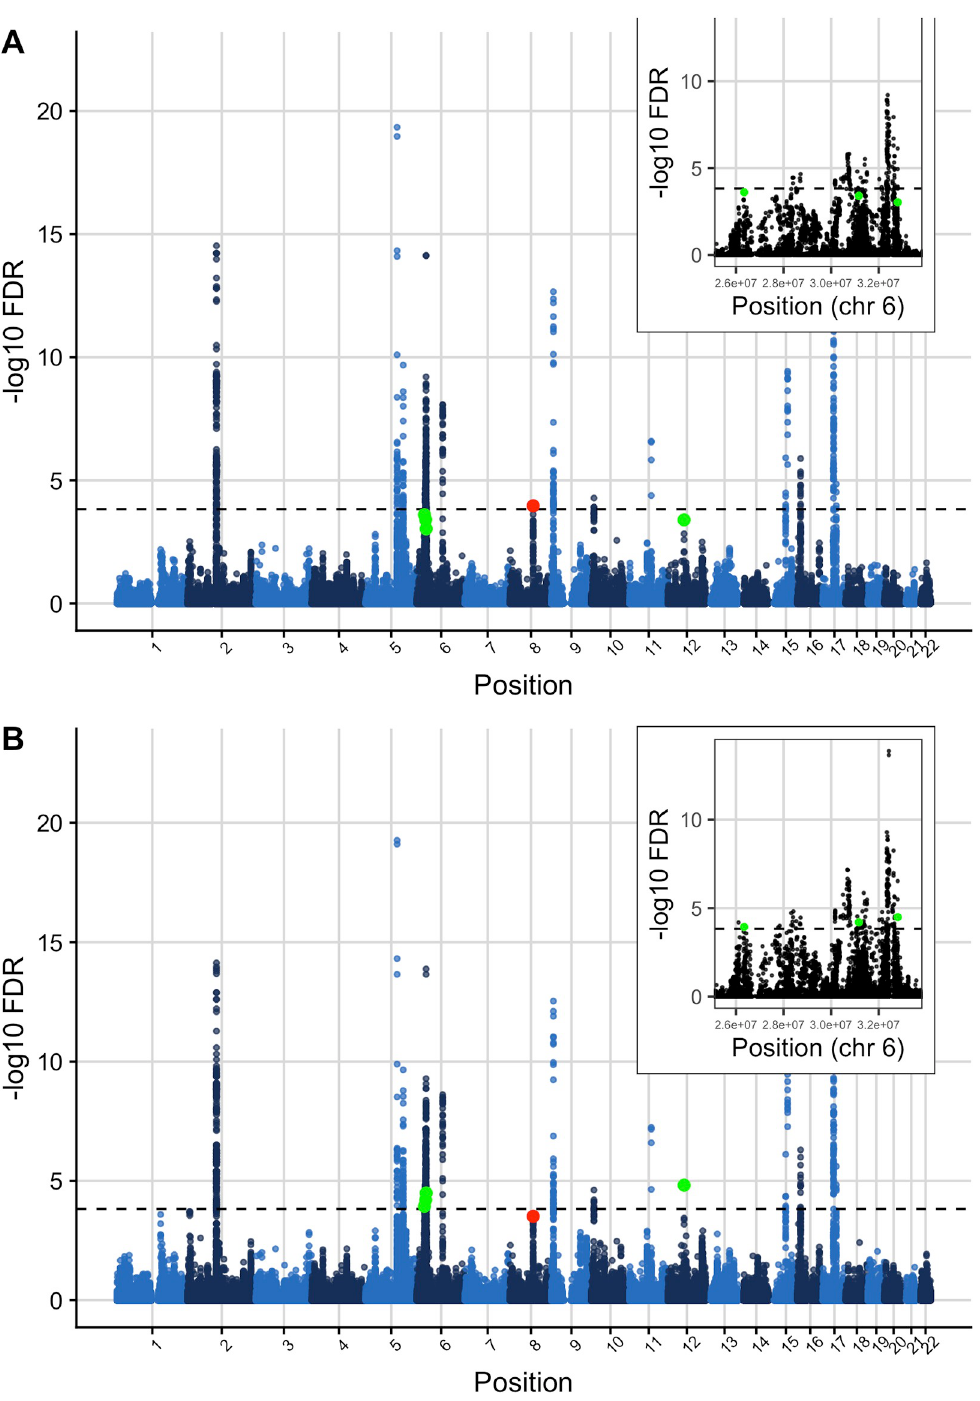
Fig 4. Manhattan plot of FDR values before and after applying Flexible cFDR to leverage H3K27ac data with asthma GWAS p -values. Manhattan plots of -log 10 FDR values before (A) and after (B) applying Flexible cFDR leveraging H3K27ac counts in asthma relevant cell types. Points are coloured by chromosome and green points indicate the four index SNPs that are newly identified as FDR significant after Flexible cFDR (rs167769, rs9467715, rs9501077 and rs4148869) whilst the red point indicates the single index SNP that was newly identified as not FDR significant by Flexible cFDR (rs12543811). Black dashed line at FDR significance threshold [ − log 10 (0.000148249)].